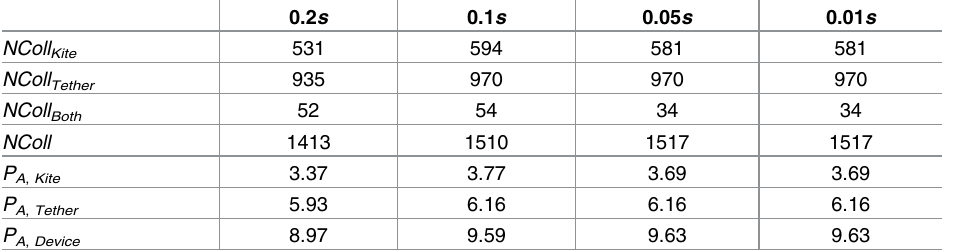
Table 2. Total number of collisions with varying timestep for the baseline case( h = 3 m , T = 8 s , D = 7 m